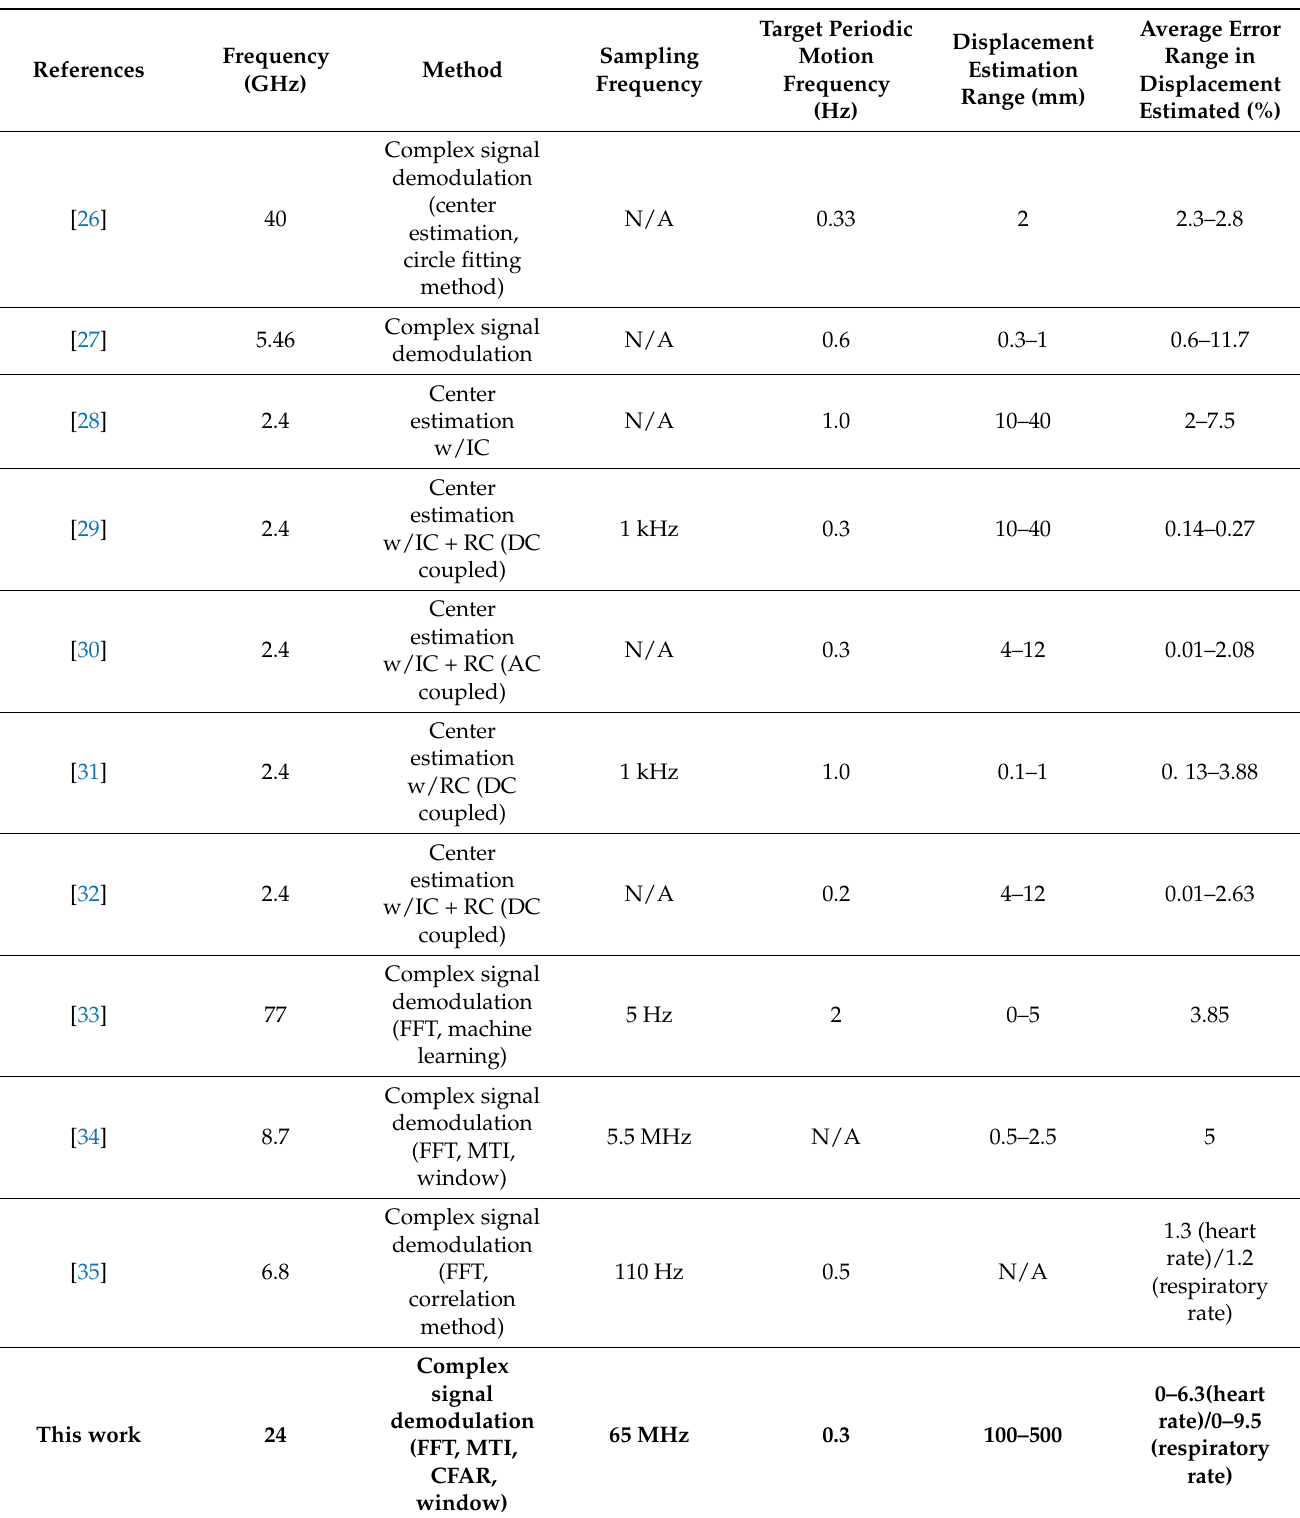
Table 3. Comparison of displacement estimation results with the reported